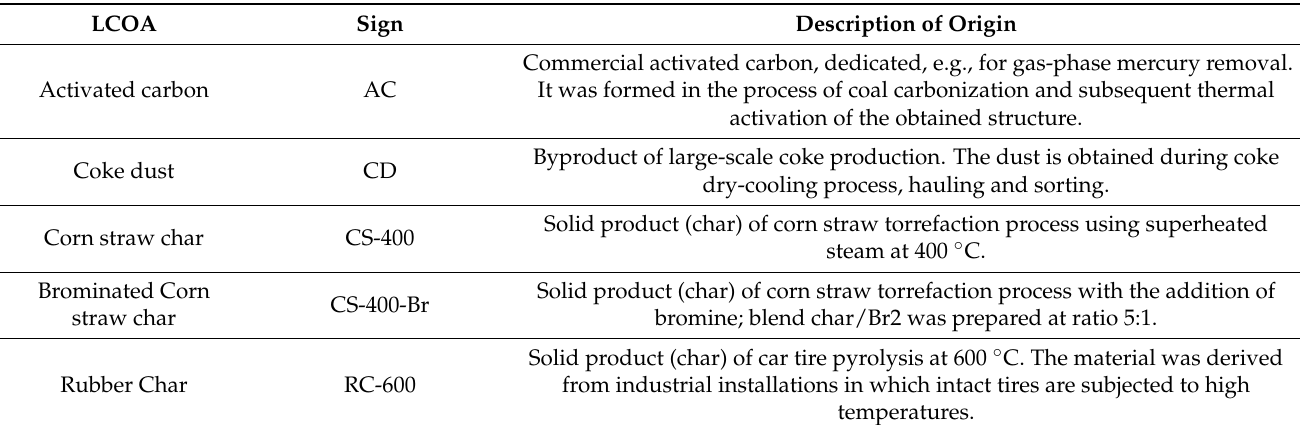
Table 1. Description of low-cost organic